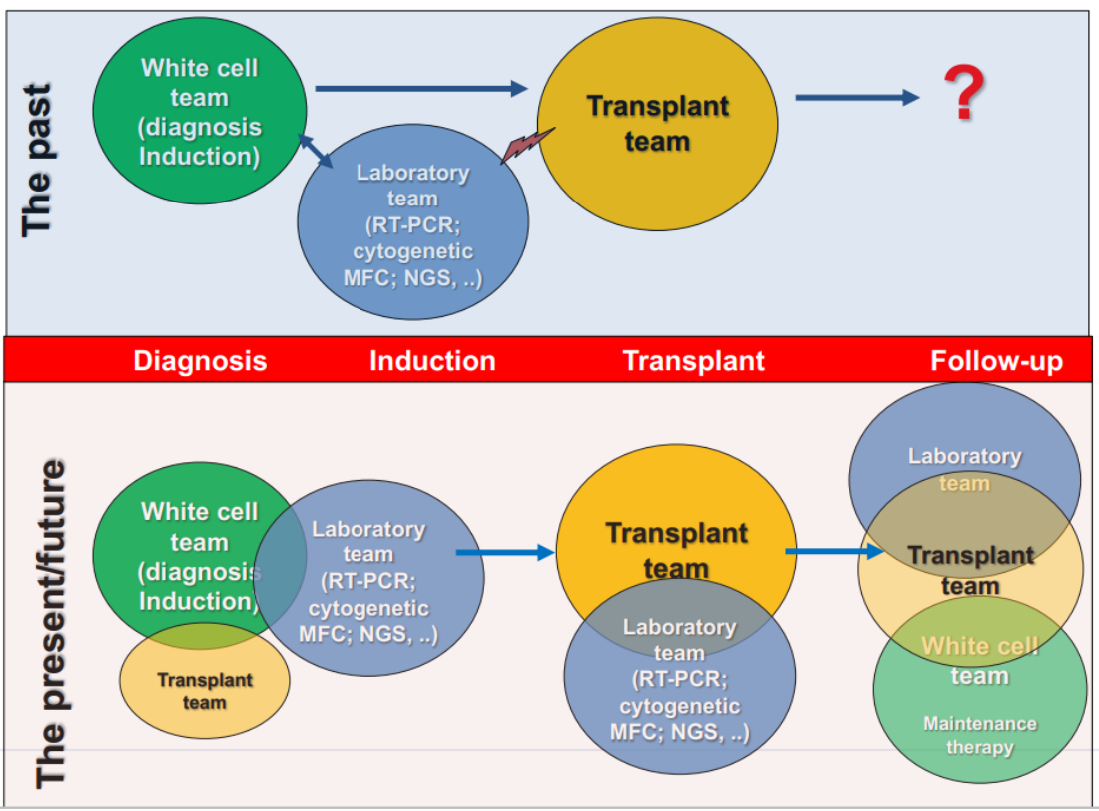
Figure 5. New approach for AML treatment: from diagnosis to post-transplant follow-up.